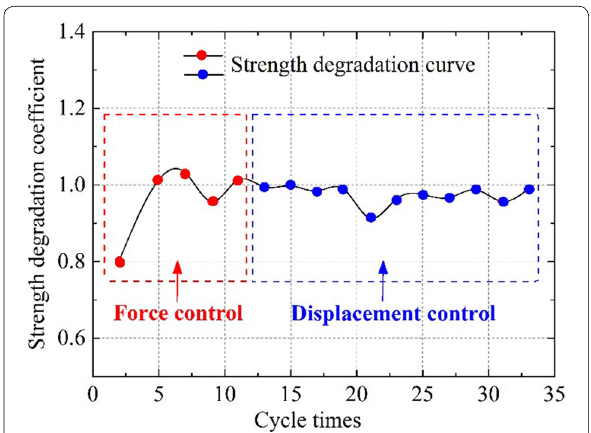
Fig. 12 Equivalent viscous damping coefficient